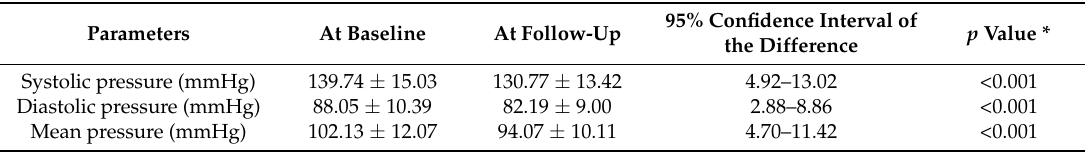
Table 2. Changes of blood pressure after magnesium supplementation in patients with essential hypertension ( N =